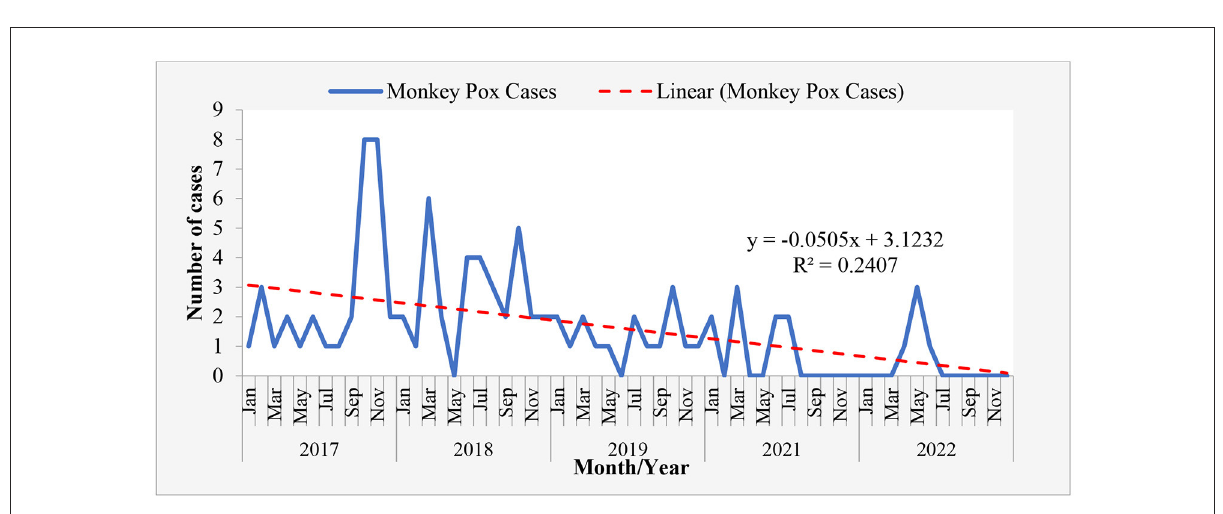
FIGURE3 Trend in Monkey-pox cases in Rivers State January 2017-June